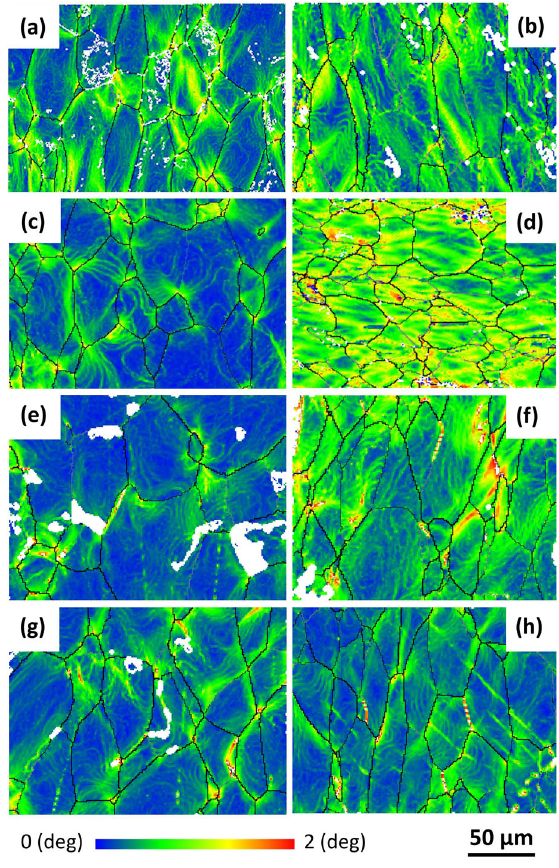
FIG. 17. Local misorientation map (KAM 3 × 3 ) through thickness close to external and internal surfaces: (a) external surface equator of EHF half-cell; (b) external surface equator of half-cell formed by spinning; (c) external surface iris of EHF half- cell; (d) external surface iris of half-cell formed by spinning; (e) internal surface equator of EHF half-cell; (f) internal surface equator of half-cell formed by spinning; (g) internal surface iris of EHF half-cell; (h) internal surface iris of half-cell formed by spinning. White zones inside the KAM maps represent non- indexed